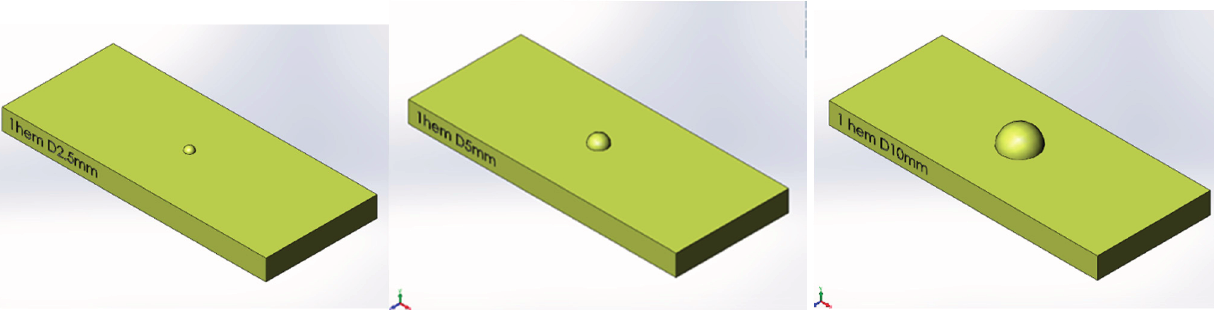
Figure 12. CAD design of the three hemisphere stimuli: 2.5 mm ( Left ); 5 mm ( Centre ) and 10 mm ( Right ) in diameter.